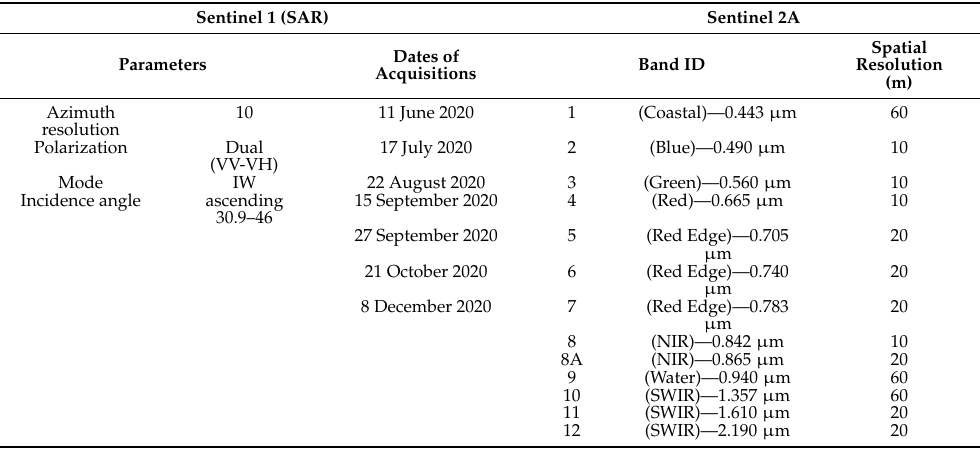
Table 2. Details of Sentinel 1, SAR, and Sentinel 2A data acquired between June and December